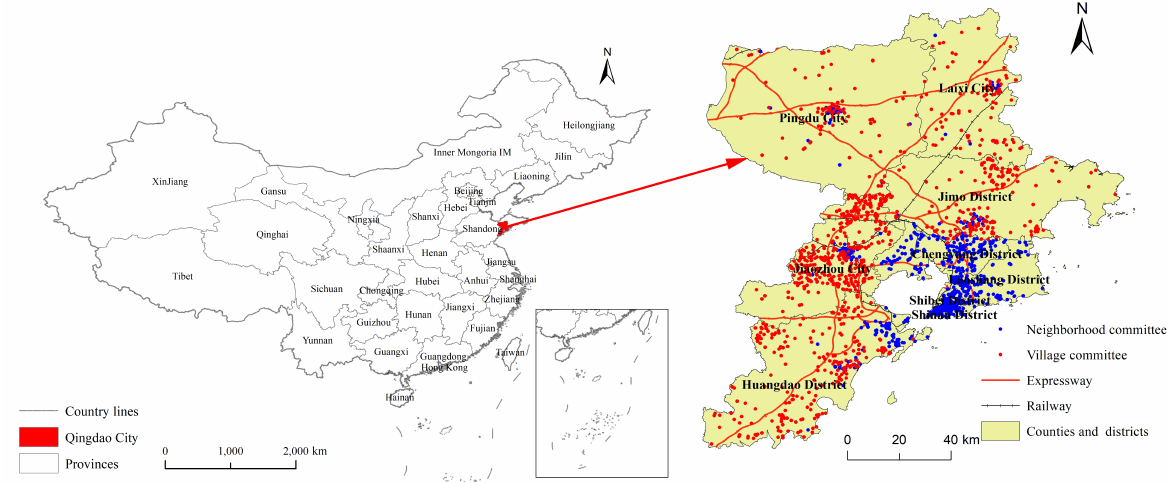
Figure 1. Distribution of the study